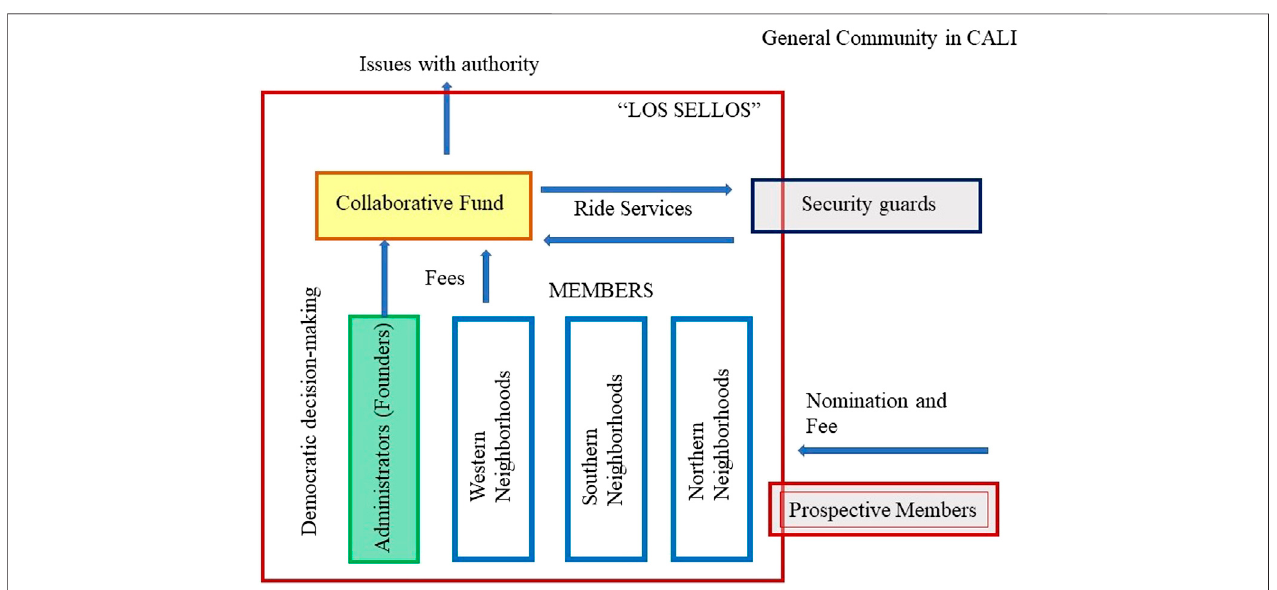
FIGURE 4 | Los Sellos horizontal heterarchySource: Elaborated by the author.